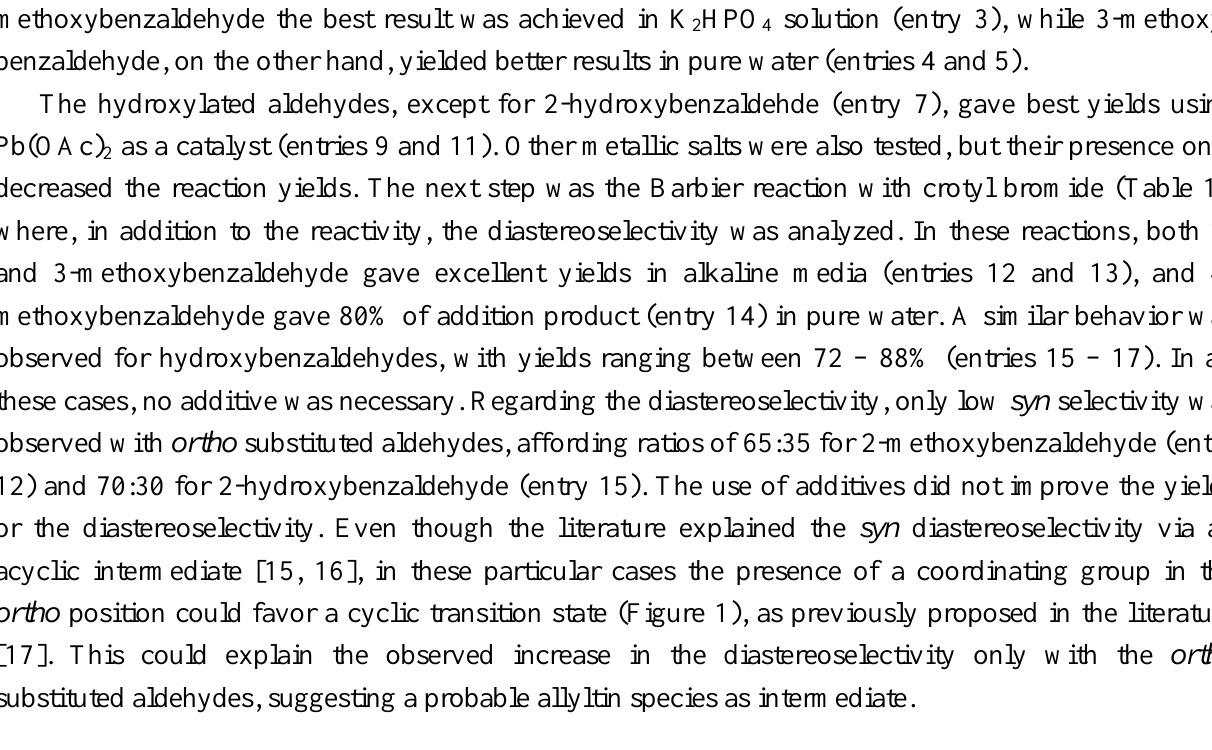
a The syn:anti ratio was determined using the ¹H-NMR signal areas for the methyl group of the homoallylic alcohols. b Dioxane (0.2 mL) was used as